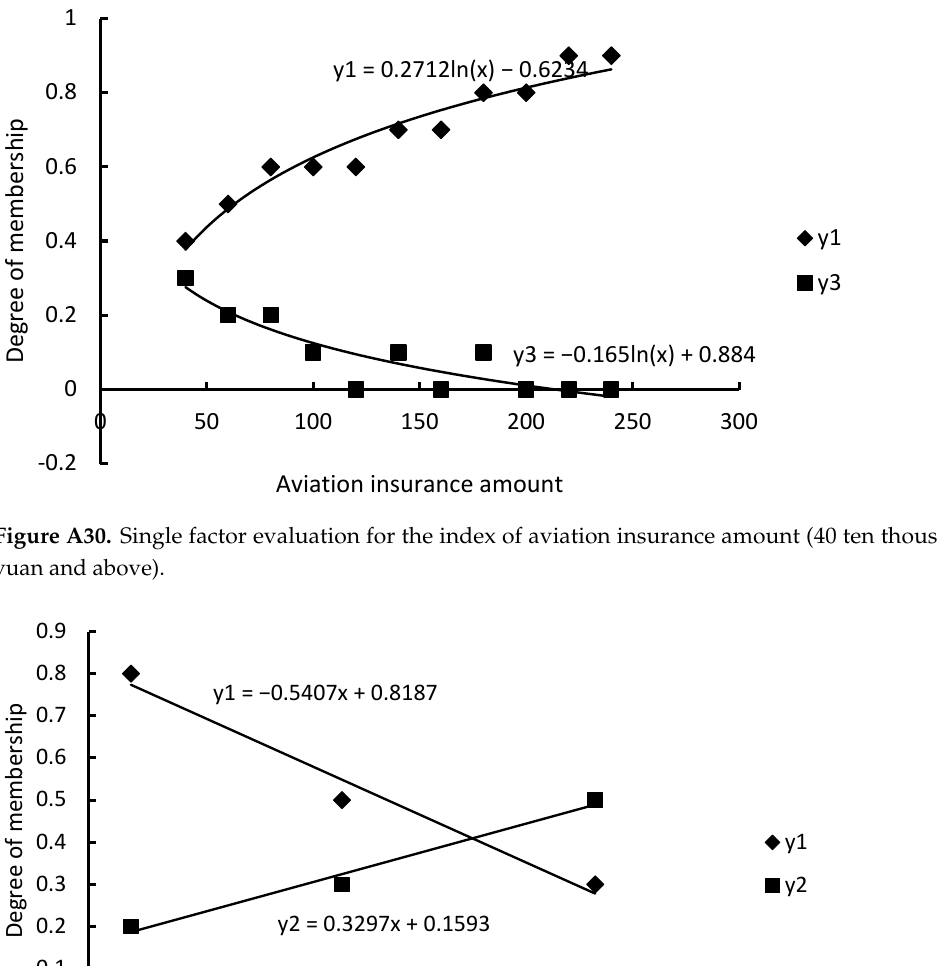
Figure A32. Single factor evaluation for the index of time of buying tickets (1–3 days before depar- ture).